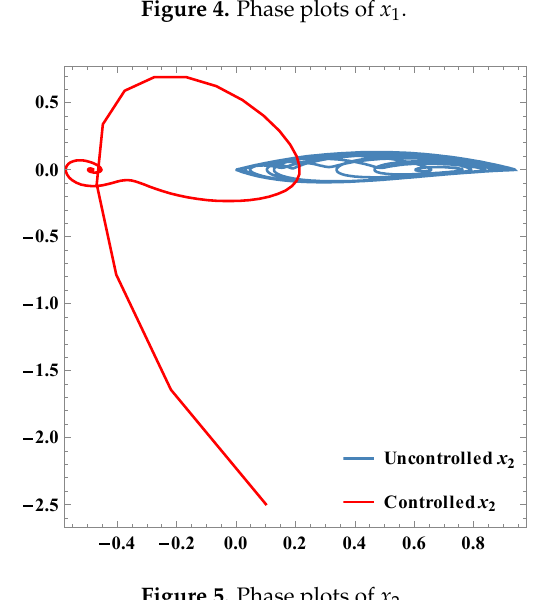
Figure 4. Phase plots of x 1 .